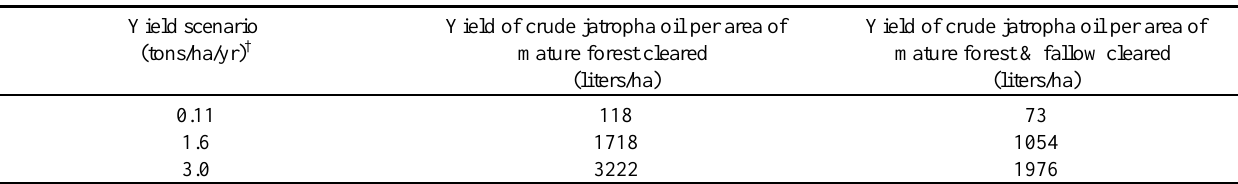
Table 5 . Estimated yield per hectare of mature and degraded forest cleared for biofuel feedstock cultivation (using a seed yield of 3.0